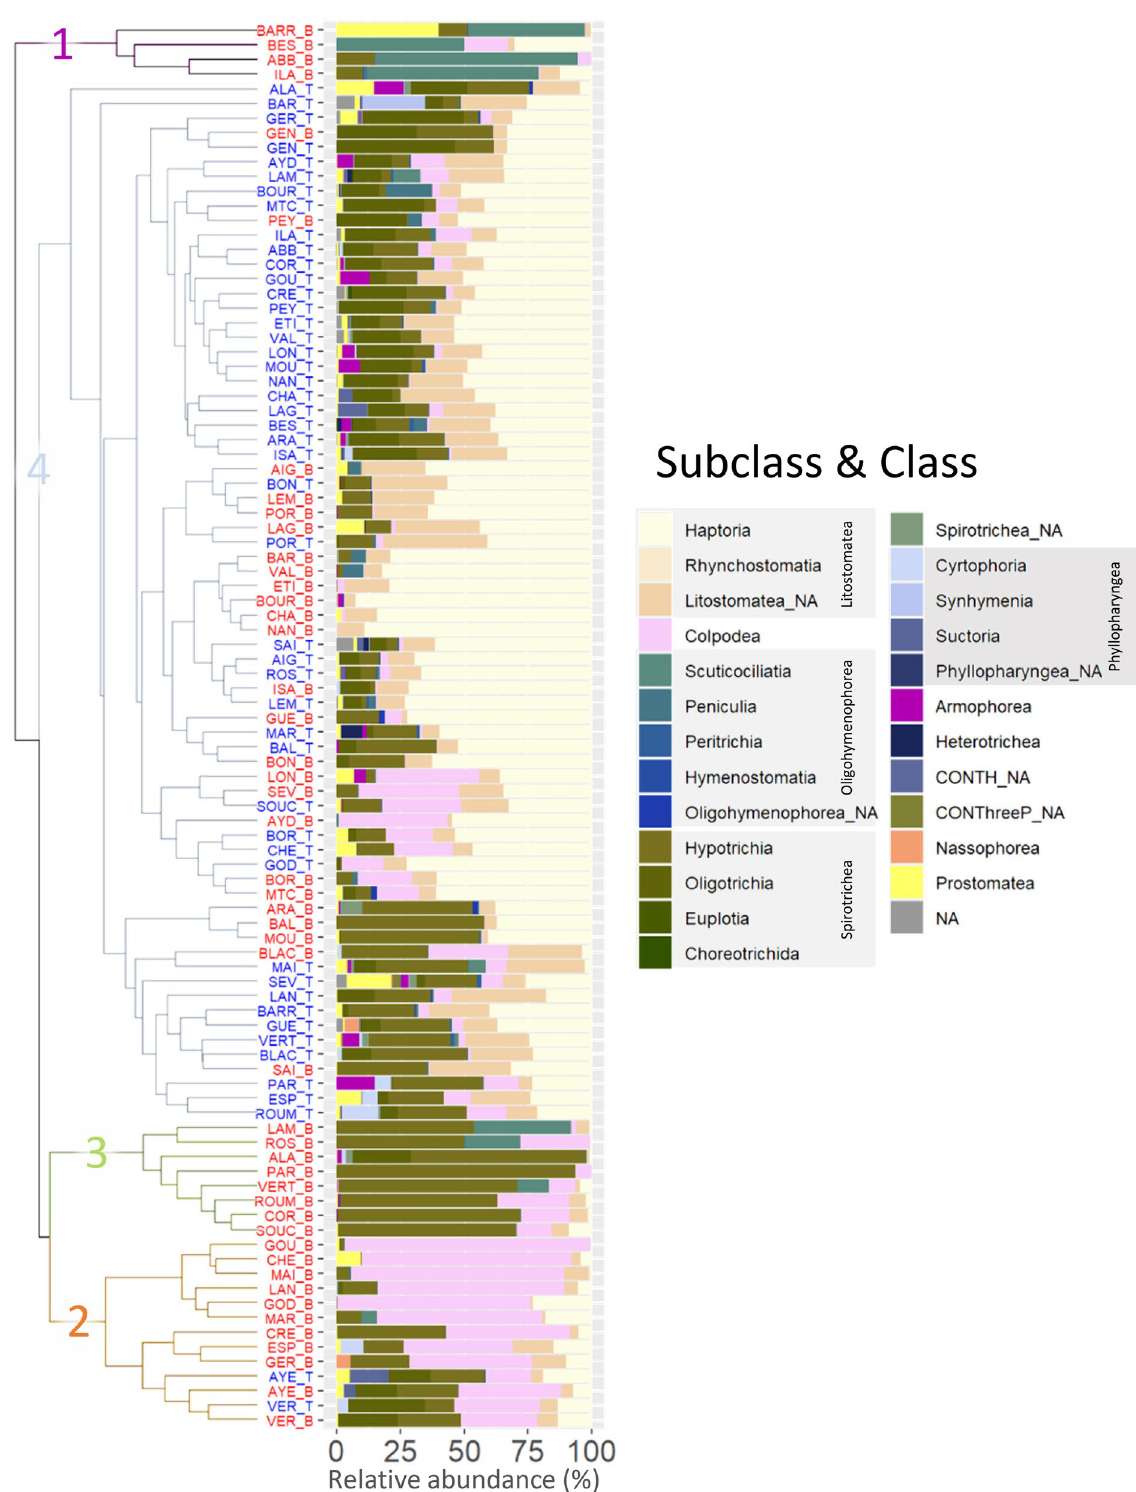
Figure 4. Dendrogram illustrating the results from the hierarchical cluster analysis. On the right side of the figure, the ciliate community composition is represented as the relative abundance of classes and subclasses (% of DNA reads). The sample labels correspond to the lake code (cf. Table S3) followed by “_T” or “_B” indicating the recent (i.e. “top”, in blue) or past (i.e. “bottom”, in red) samples respectively. In the legend, ClassName _NA was used whenever the Subclass could not be